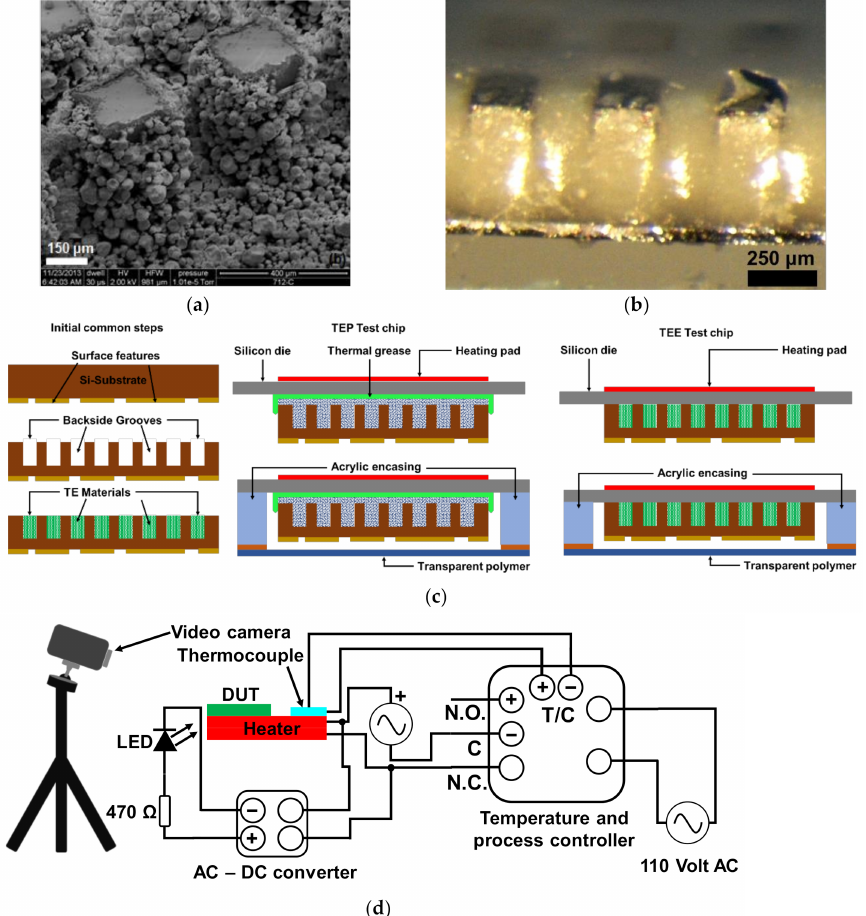
Figure 4. ( a ) SEM images of backside grooves filled with TEP microspheres as actuator material. ( b ) Optical image of backside grooves filled with TEP-elastomeric actuator material. ( c ) Fabrication schematic of heat-triggered transience test chip with TEP and TEE material. ( d ) Schematic of test set-up for heat-triggered transience